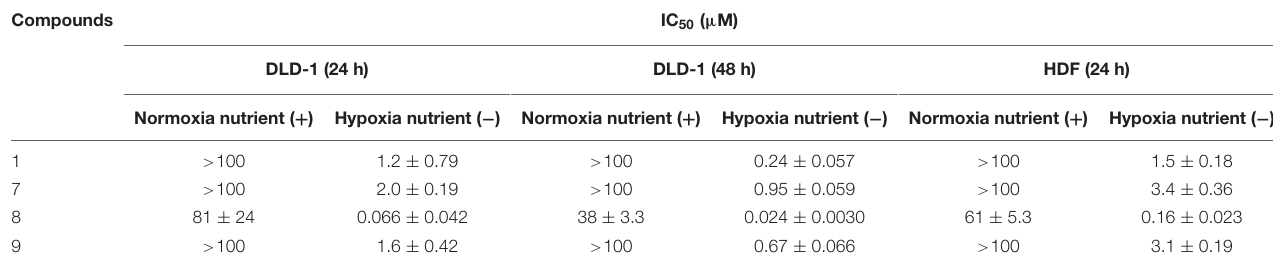
TABLE 5 | IC 50 values of 1 and its derivatives on cultured cancerous (DLD-1) and non-cancerous (HDF) human cells at 24 or 48 h. Compounds IC 50 ( µ M)